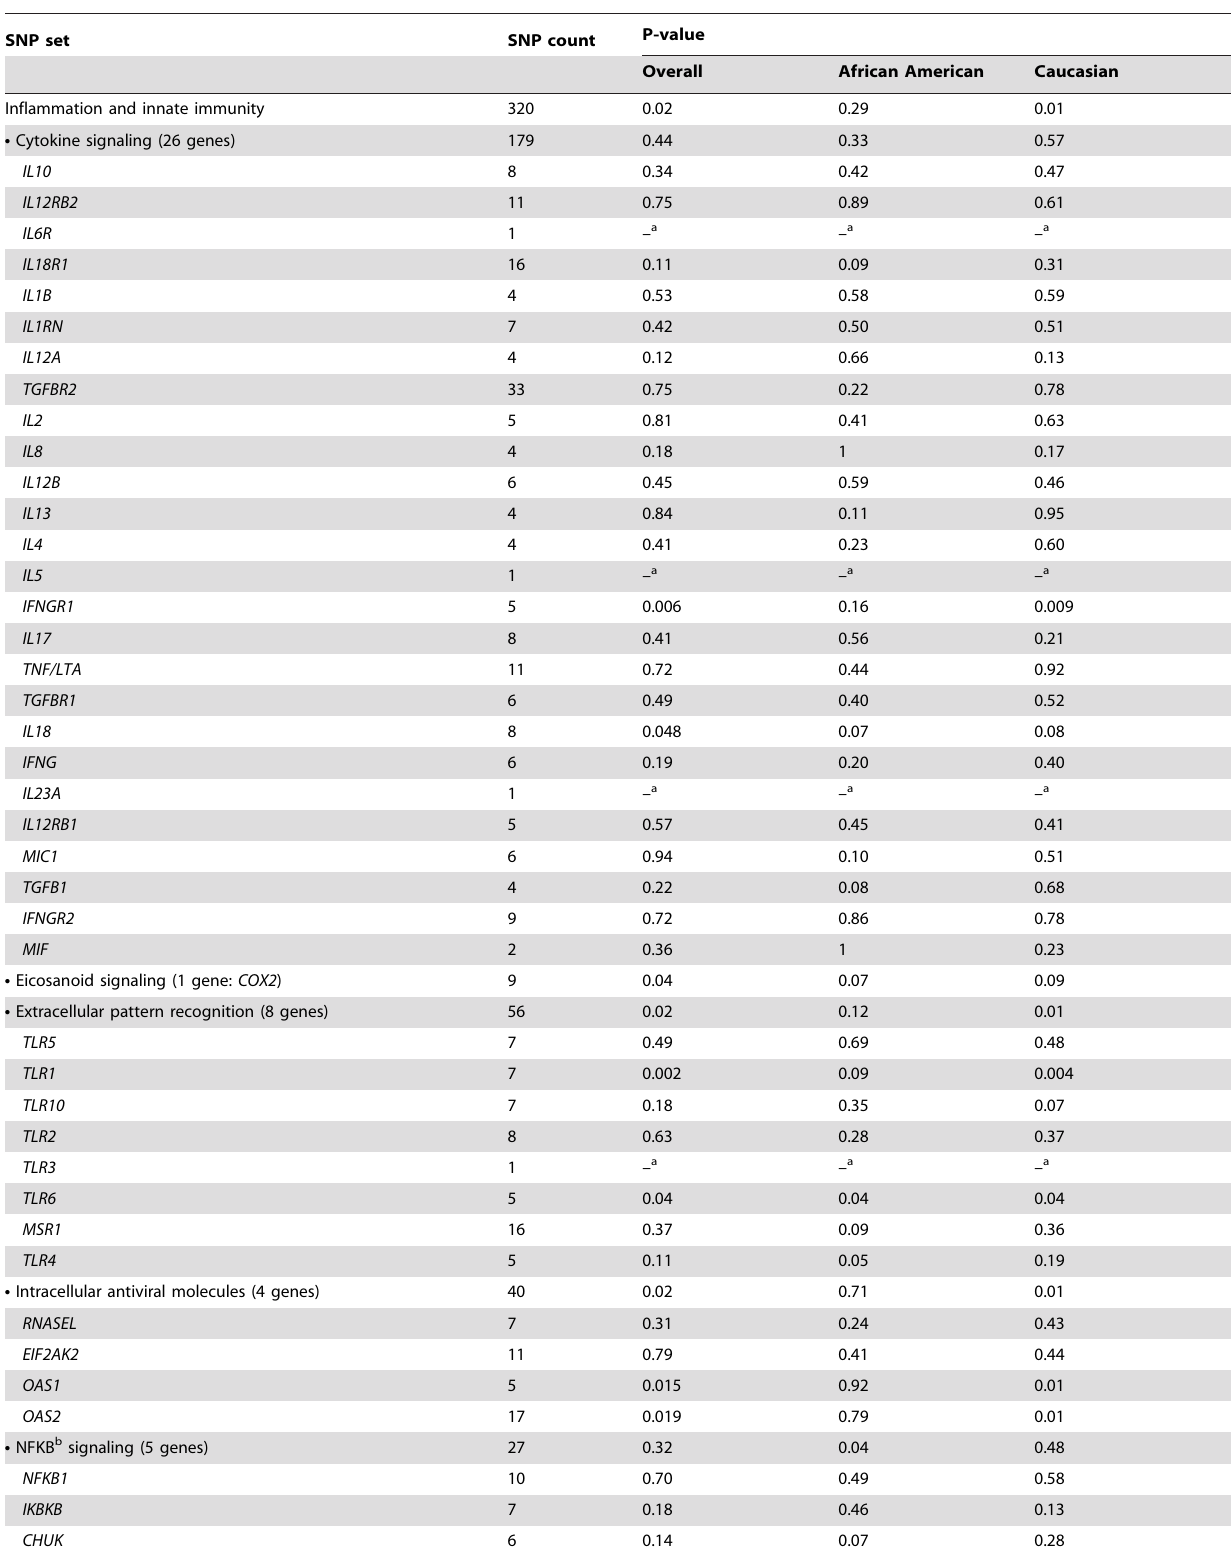
Table 2. Association of the whole pathway, sub-pathways, and genes of innate immunity and inflammation with advanced prostate cancer risk.